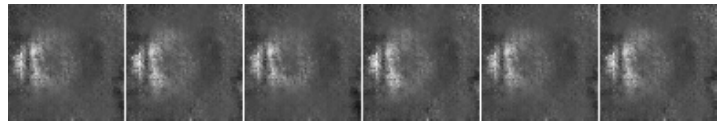
Figure 14. Blurry generated images with mode collapse visible.